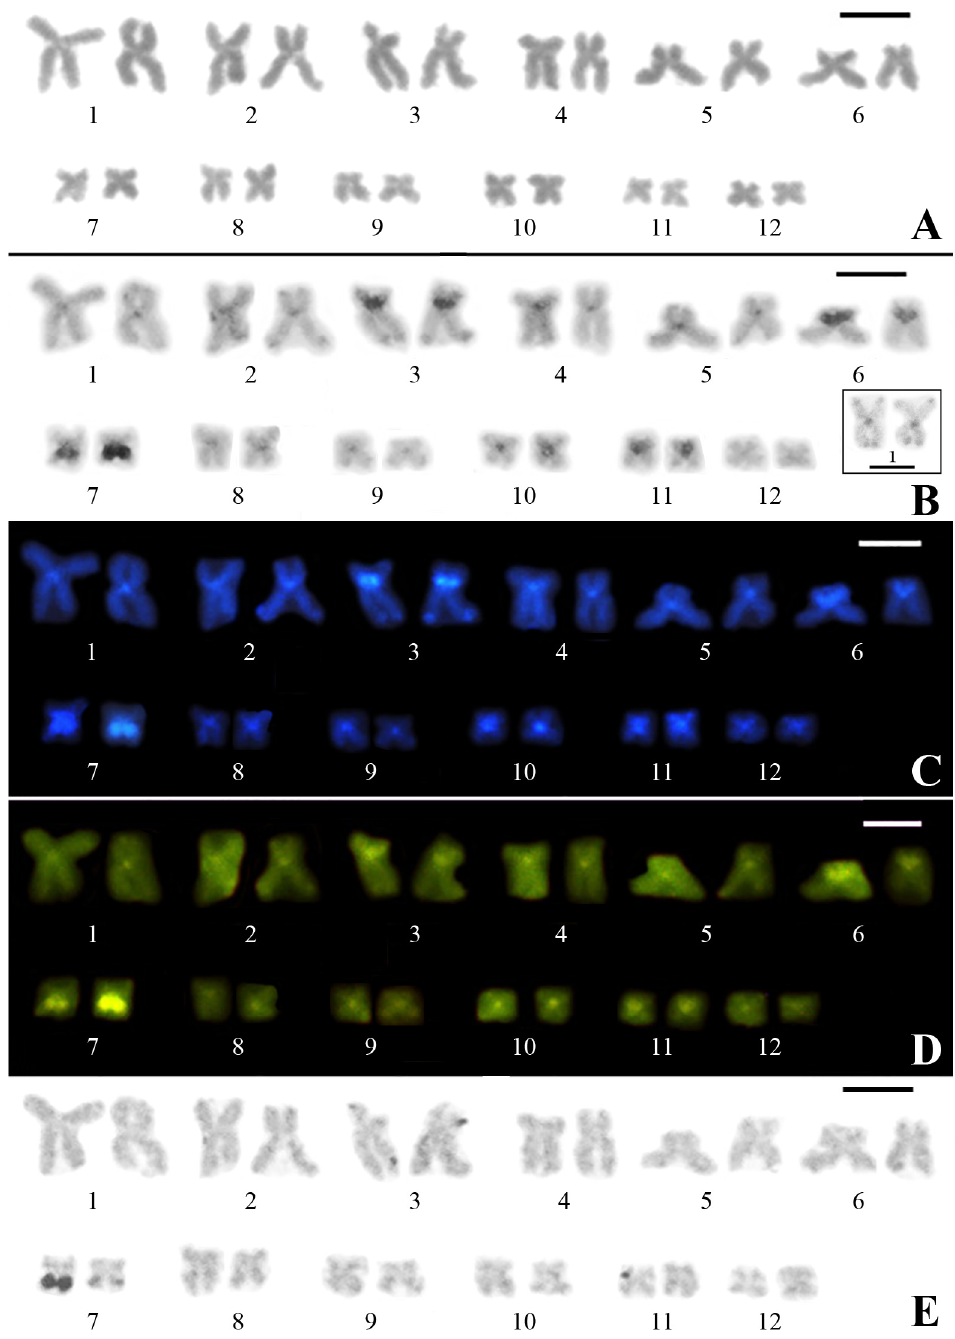
Figure 1. Karyotype of a female of Pseudis fusca from Carlos Chagas–MG subjected to Giemsa conventional staining ( A ), C-banding ( B ), C-banding followed by DAPI ( C ), and MM staining ( D ), and silver impregnation by the Ag-NOR method ( E ). The inset in ( B ) shows chromosome pair 1